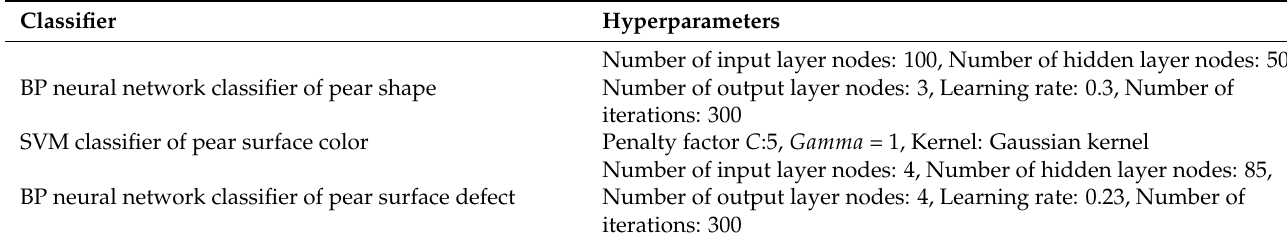
Table 4. Classifier hyperparameter